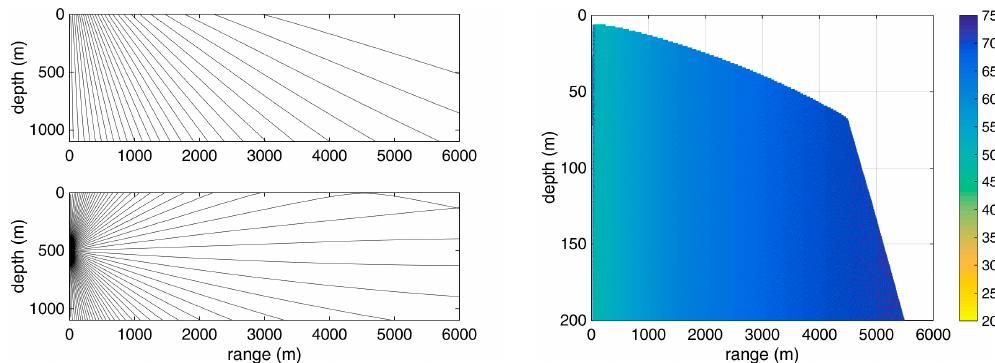
Figure 5. Predicted geometry of direct ( bottom left ) and surface-reflected ( top left ) acoustic rays from a source at a depth of 500 m in the sound speed profile of Figure 3. Right: Area where the TDOA between direct and surface-reflected arrivals is larger than 7 ms. The colors in that area denote the ray-theoretic transmission loss (TL)—scale on the right in dB—without absorption.